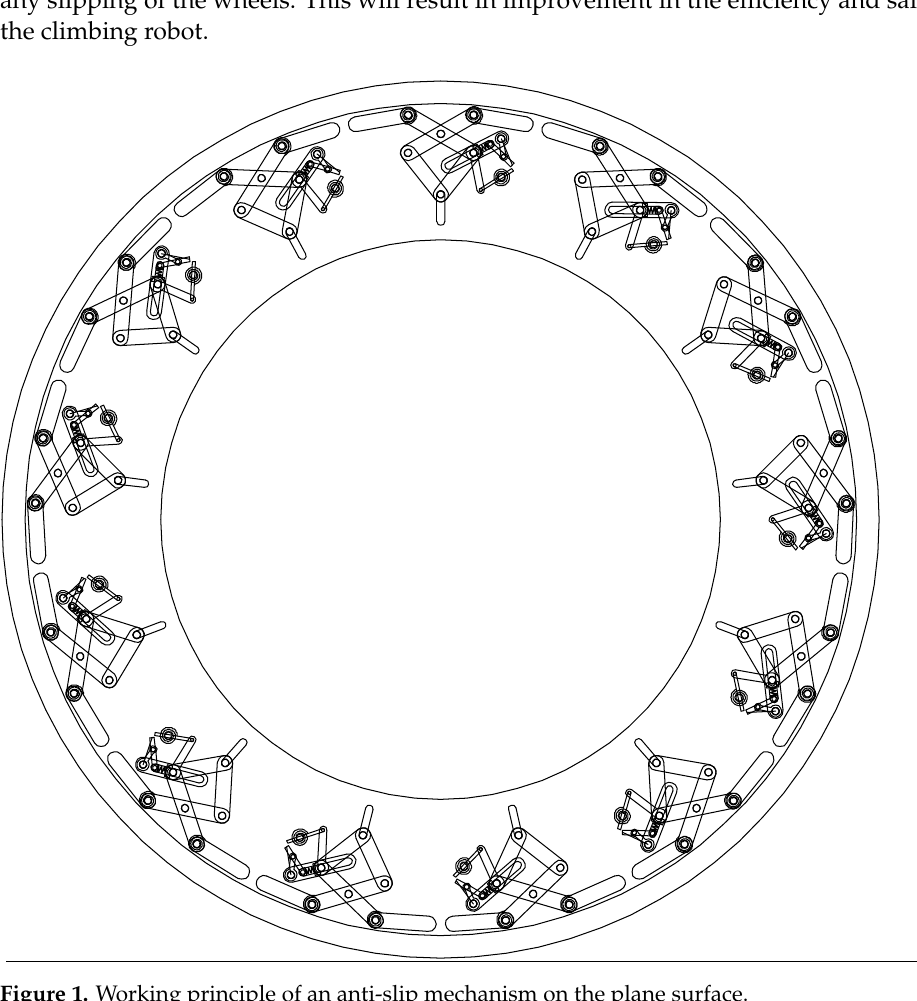
Figure 1. Working principle of an anti-slip mechanism on the plane